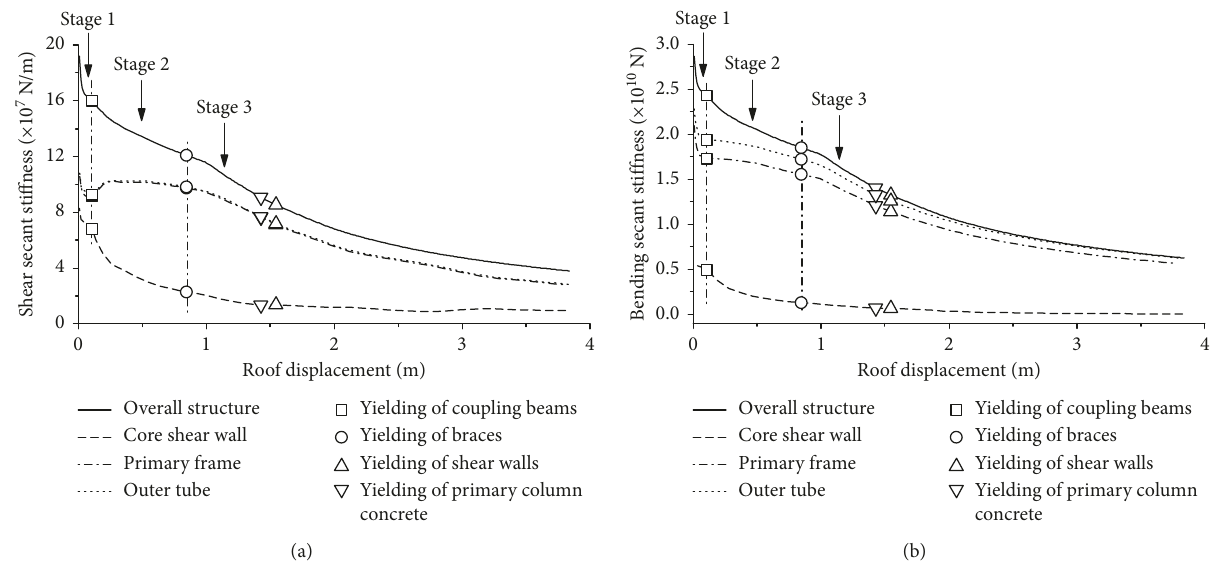
Figure 18: Stiffness degradation process of model 5MXBC: (a) shear stiffness degradation; (b) bending stiffness